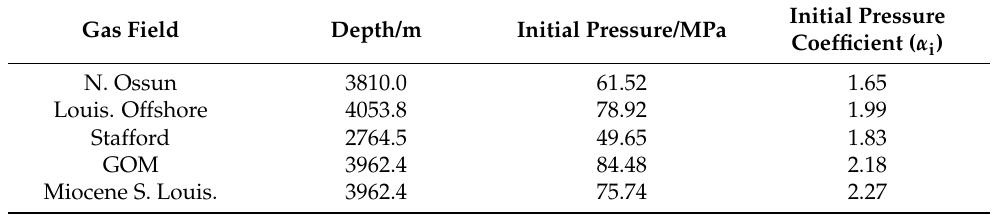
Table 1. Initial production data of the five typical abnormally high-pressured gas